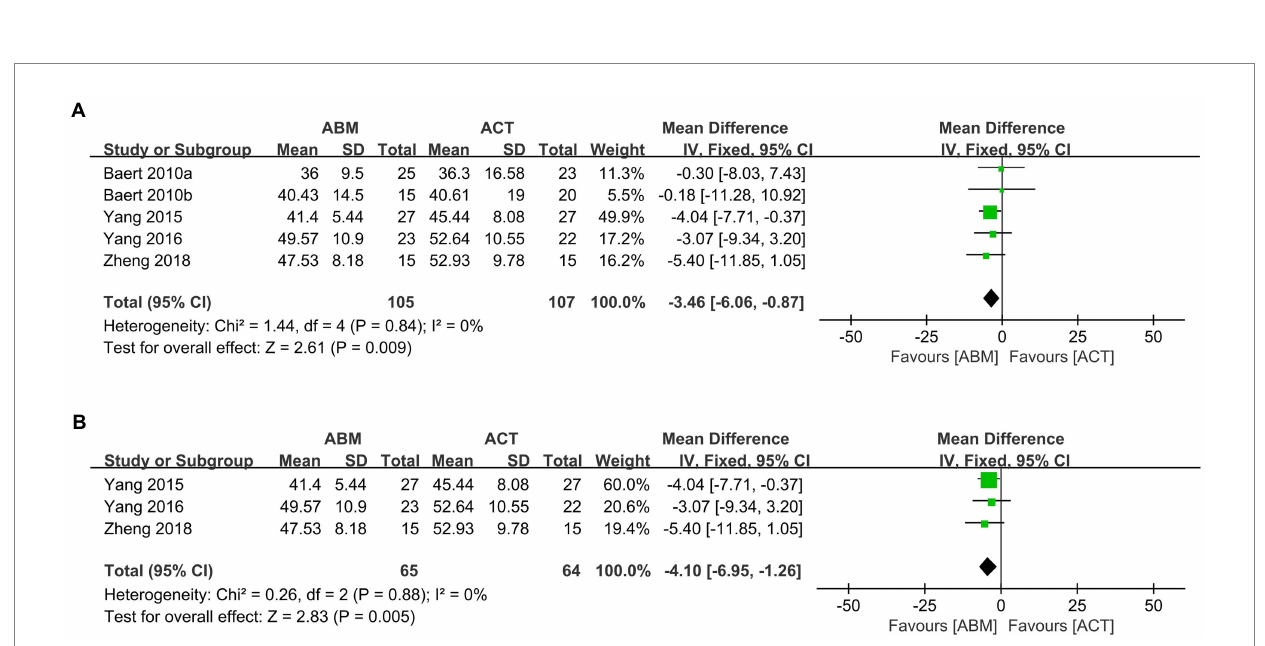
FIGURE 6 (A) Forest plot of rumination outcome in comparison with ABM versus ACT. (B) Forest plot of rumination outcome in comparison with ABM versus ACT after removing high risk-of-bias